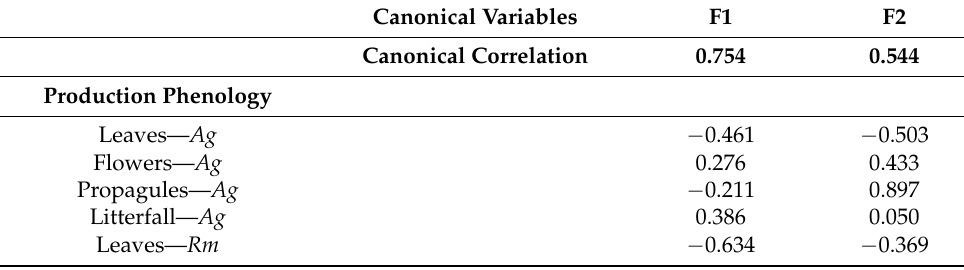
Table 7. Canonical correlation for pairs of linear combinations between the phenological